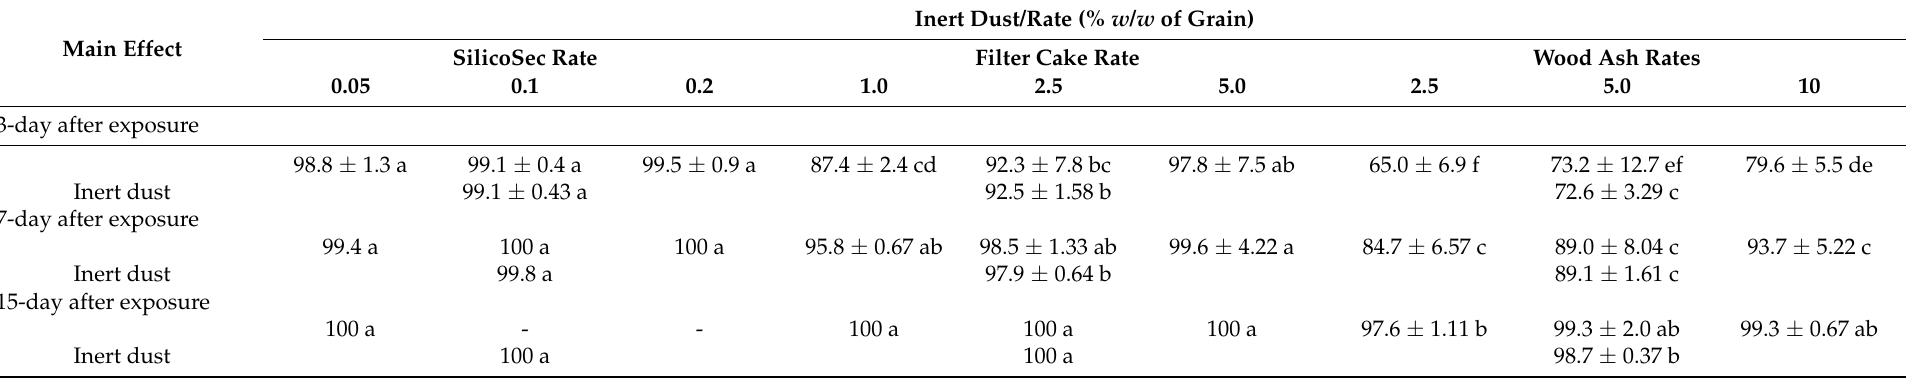
Table 5. Main effects ( ± SE) of inert dust (SilicoSec, filter cake, and wood ash) and their rates on the percent of the mortality of adult maize weevil 3, 7, and 15 days after